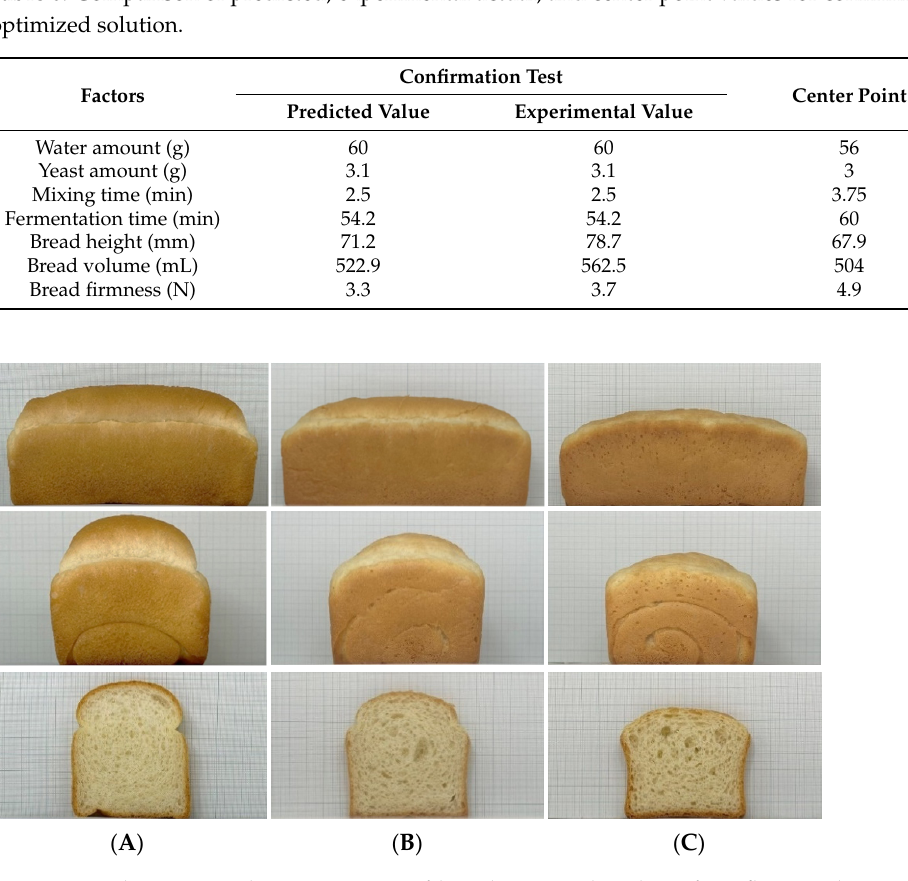
Figure 7. Side views and cross ‐ sections of bread prepared with ‘O ‐ free’ flour at the optimized con ‐ ditions. ( A ), Bread with Bread flour B; ( B ) Bread with O ‐ free flour prepared at the optimized condi ‐ conditions. ( A ), Bread with Bread flour B; ( B ) Bread with O-free flour prepared at the tion; ( C ) Bread with O ‐ free prepared at the center point.